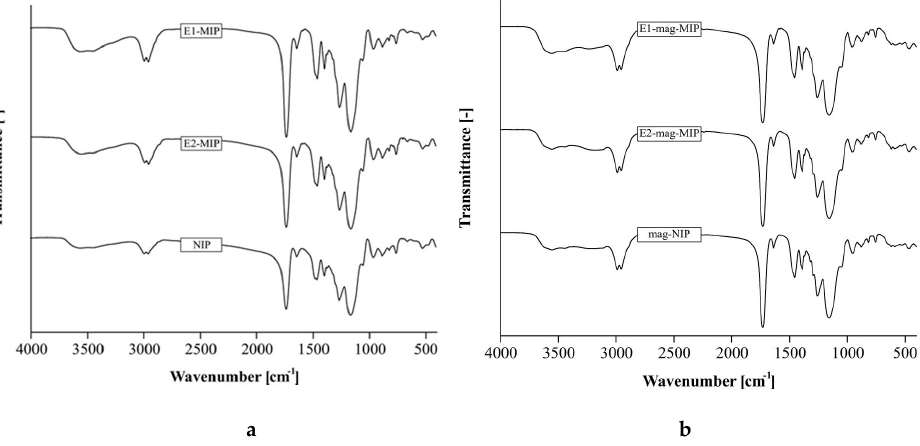
Figure 3. The FT-IR spectra of: ( a ) E1-MIP, E2-MIP and NIP; ( b ) E1-mag-MIP, E2-mag-MIP, and mag- NIP.